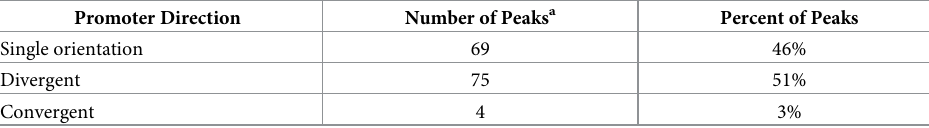
Table 2. Relationship to Promoters of Ash1, Tup1, Rpd3 co-localized (ATR) peaks. Promoter Direction